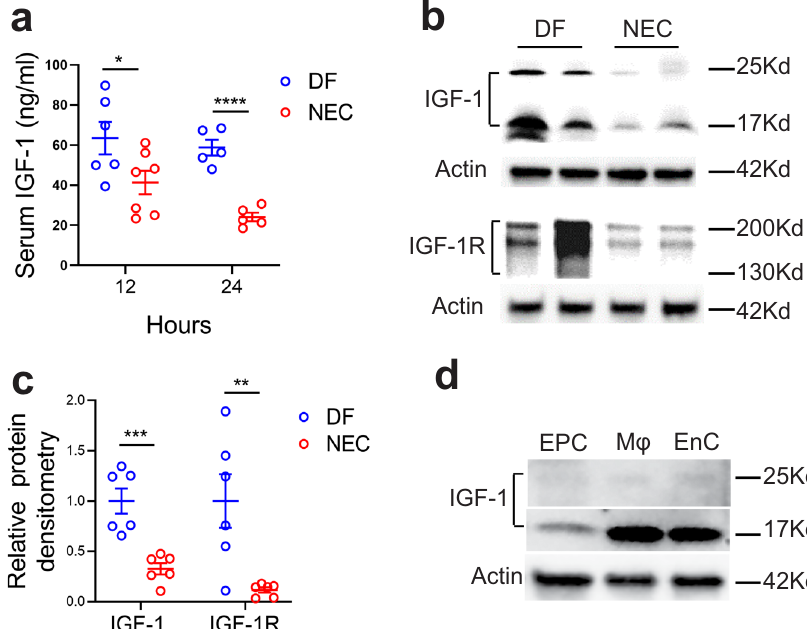
Fig. 2 IGF-1 and IGF-1R expression are decreased prior to experimental NEC. Day 1 neonatal mice were left with the dam (DF) or submitted to the experimental NEC model. a 12 and 24 h later, their serum was obtained, and IGF-1 level was determined by ELISA. n = 5 – 7/group (see dots in panels and